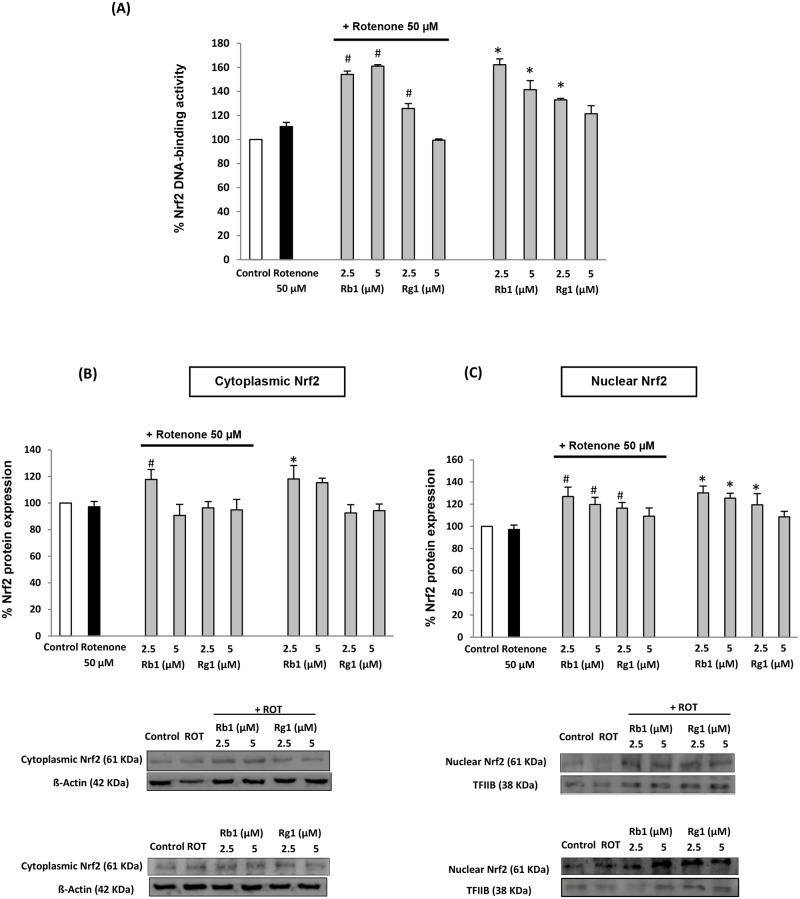
Involvement of Nrf2 signaling pathway in the cytoprotective actions of ginsenosides Rb1 and Rg1.(A) Degree of activation of Nrf2 factor in nuclear extracts of SH-SY5Y cells. (B) Effects of ginsenosides on Nrf2 protein levels in cytoplasm and (C) in nucleus; representative blots from purified cytoplasmic and nuclear fractions. Cells were pre-treated with ginsenosides for 24 h with/without later exposure to rotenone 50 μM for other 24 h. Data are expressed in percentage relative to untreated control cells. Means ± SD, * p < 0.05 Vs control, # p < 0.05 Vs rotenone-treated cells.